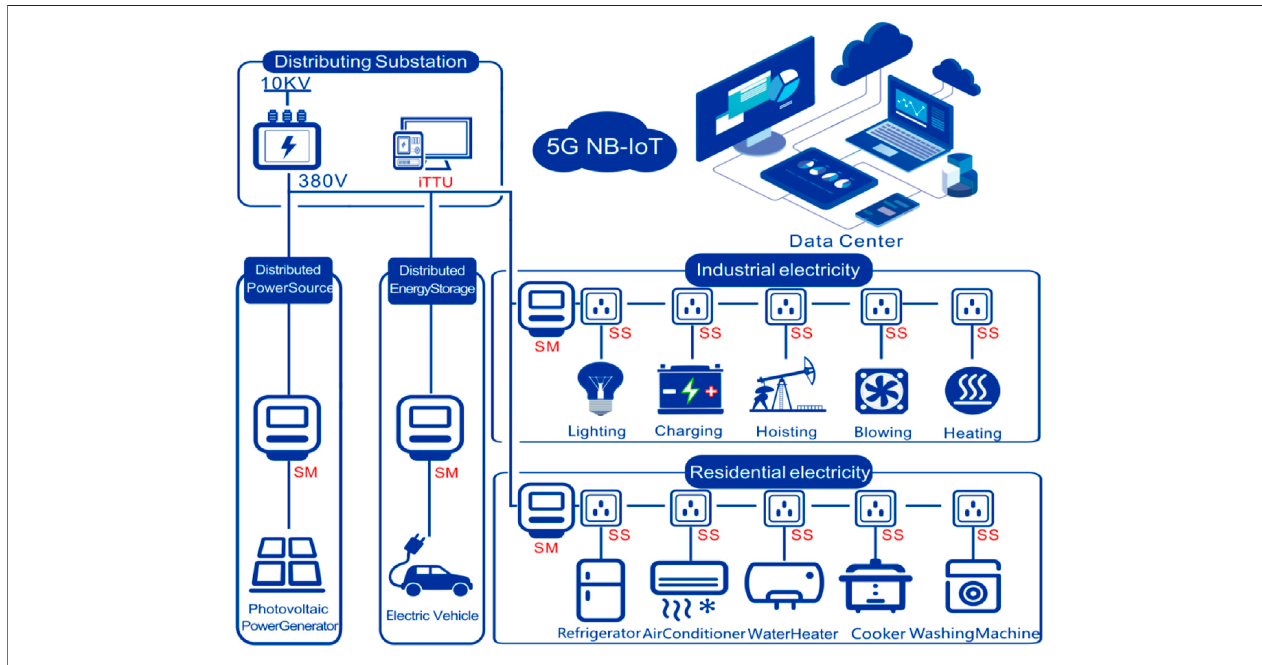
FIGURE 1 | Demand side in the smart